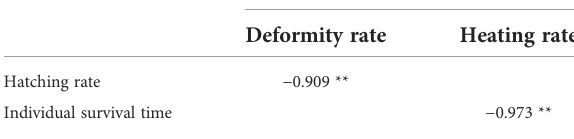
TABLE 2 Spearman rank correlation analysis results on hatching and deformity rates, individual survival time and heating rate.